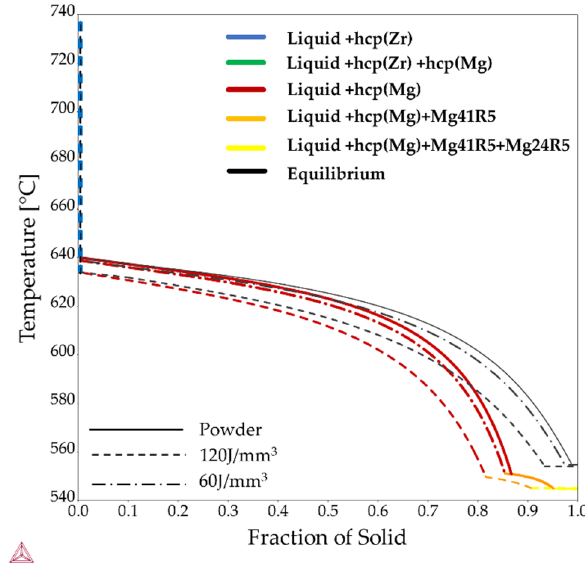
Figure 7. Scheil–Gulliver simulation showing the solidification paths in comparison to equilibrium for the alloying contents given in Table 3, using the Thermo-Calc TCS Mg-based alloys Database version 5.0 [49,50]. The higher thermal stability of the hcp-Zr observed in the equilibrium phase diagram is also visible in the calculated results of Scheil–Gulliver simulations for the sample printed with 120 J/mm 3 , where it corresponds to the green line. However, the temperature interval was too small to be visible in the graph.